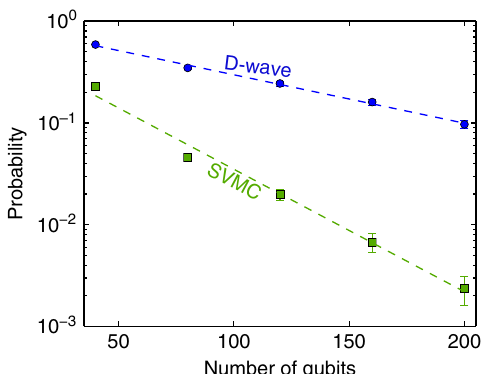
Figure 10 | Success probability for a glass of clusters as a function of the number of qubits. We fit the mean probability of success P ( n q ) p exp( (cid:2) a n q ) as a function of the number of qubits n q (dashed lines). The fitting exponent a for the D-Wave Two data is (1.1 ± 0.05) (cid:8) 10 (cid:2) 2 , while the fitting exponent for the SVMC numerics is (2.8 ± 0.17) (cid:8) 10 (cid:2) 2 . The error estimates for the exponents (s.e.m.) are obtained by